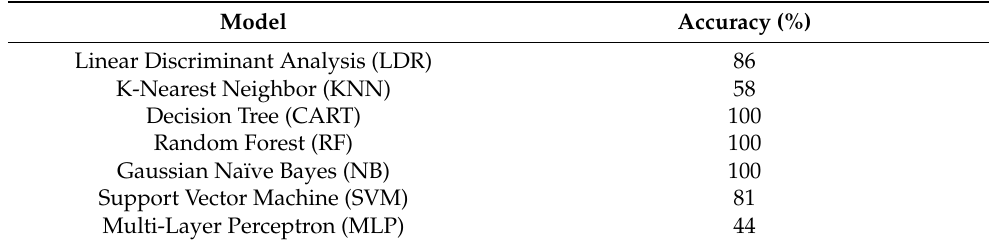
Table 4. Accuracy of fault prediction for different ML models using a 10-year-old PV installation (Figure 7a). Model Accuracy (%) Linear Discriminant Analysis (LDR) 86 K-Nearest Neighbor (KNN) 58 Decision Tree (CART) 100 Random Forest (RF) 100 Gaussian Naïve Bayes (NB) 100 Support Vector Machine (SVM) 81 Multi-Layer Perceptron (MLP) 44